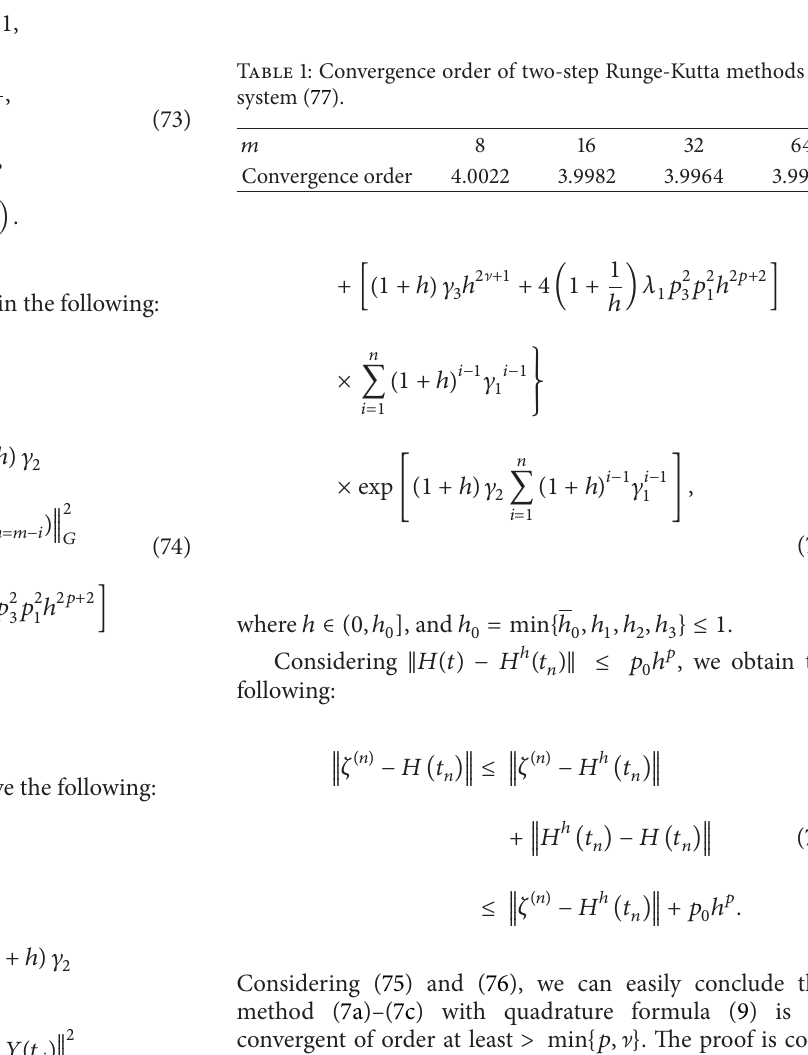
Figure 1: The numerical solution of (79a) and (79b) for (77) with ℎ = 0.1 .